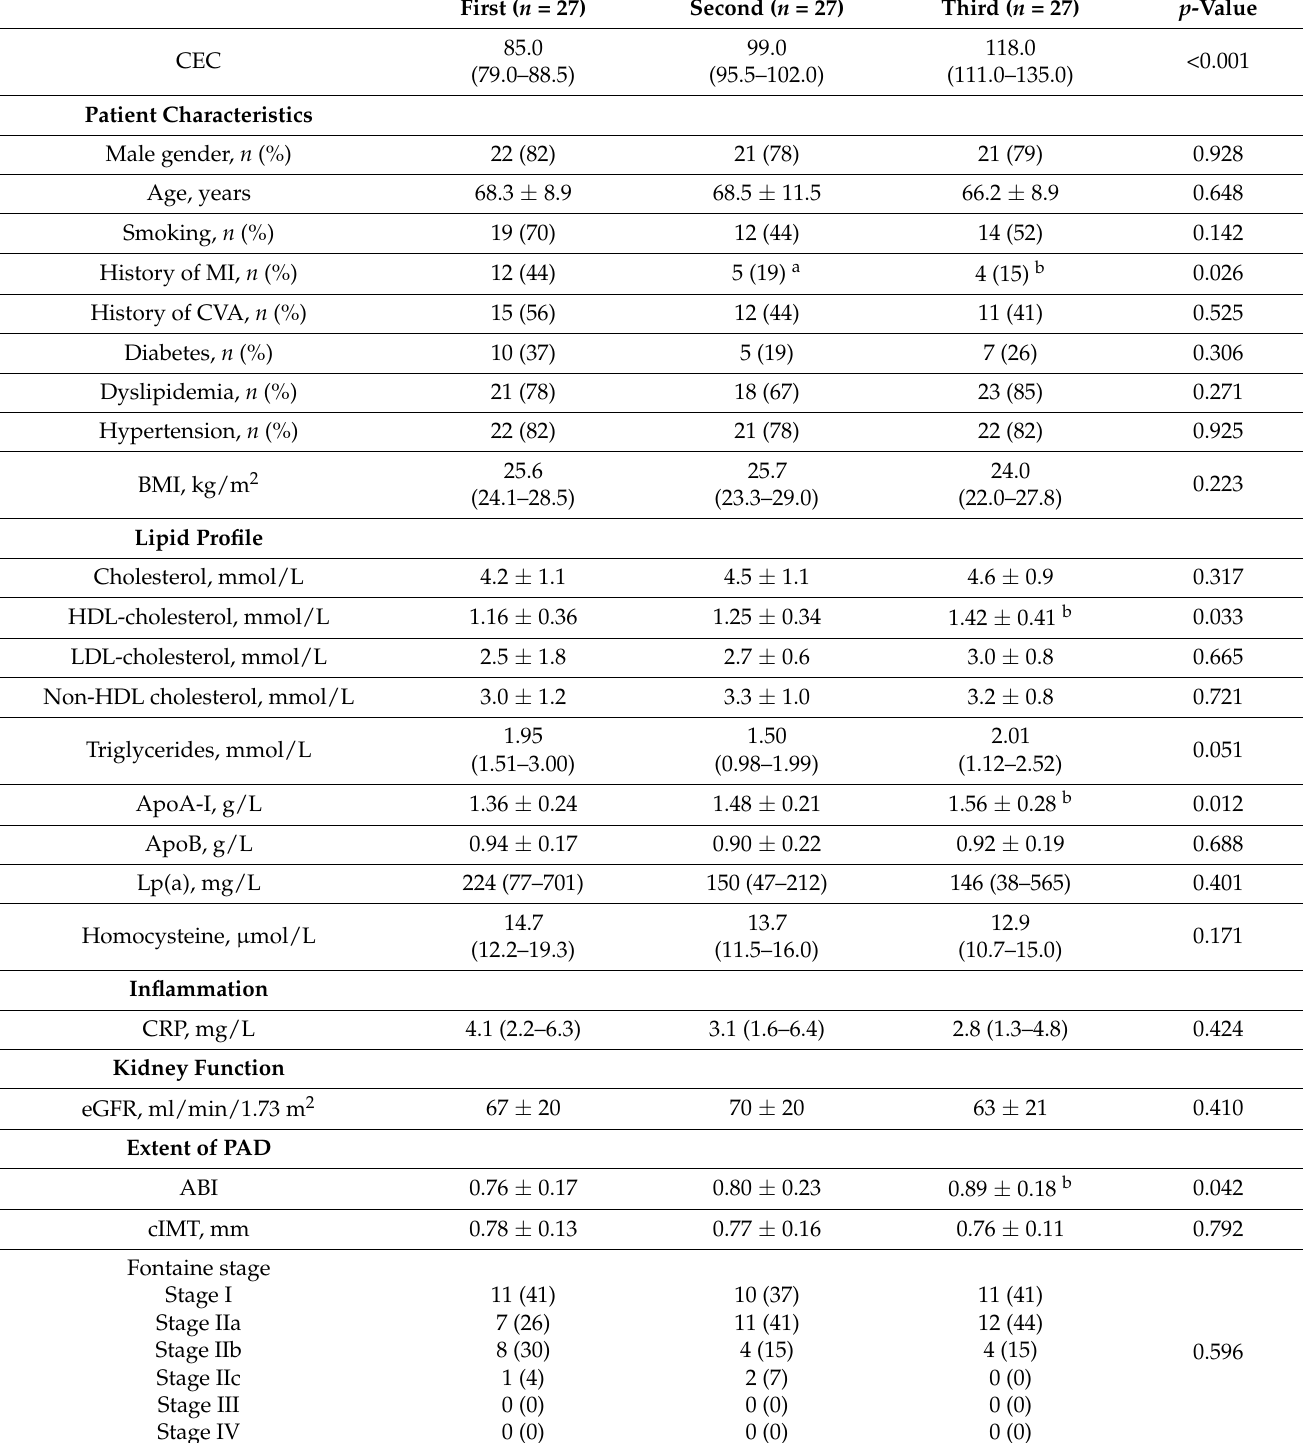
Table 1. Patient characteristics by gender-stratified tertiles of